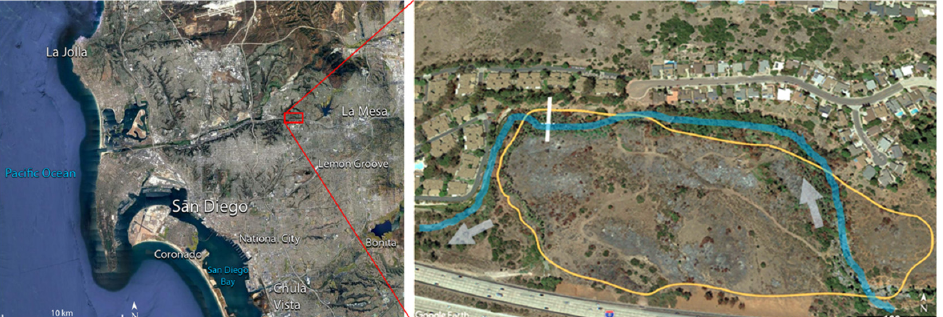
Figure 1. The study area, Alvarado Creek, is located in San Diego, California (left image). A Google Earth Image of the study reach (in blue) in Alvarado Creek (right image). The arrows indicate the direction of streamflow. The orange line denotes the Del Cerro fire perimeter. The solid white line is the approximate location of a transect established in the study site where soil samples were collected. The pebble count method to estimate stream-bed material was conducted approximately along the dotted line, where the transect intersects the study reach.